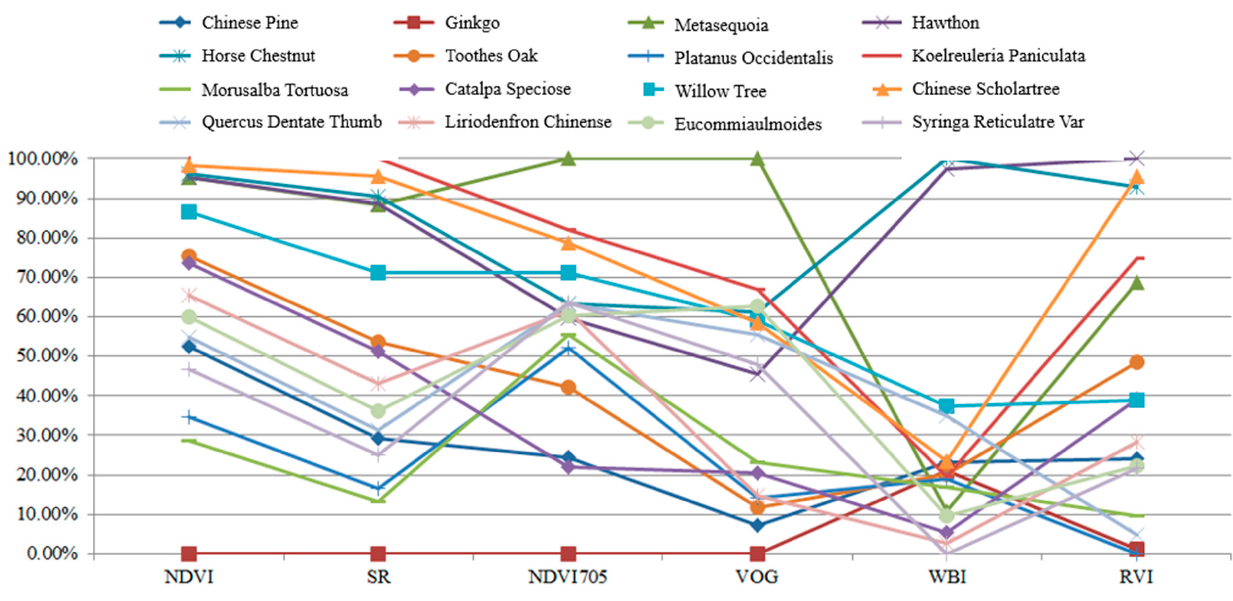
Figure 13. Normalized parameters of the employed leaves. Table 6. Vegetation parameters results.